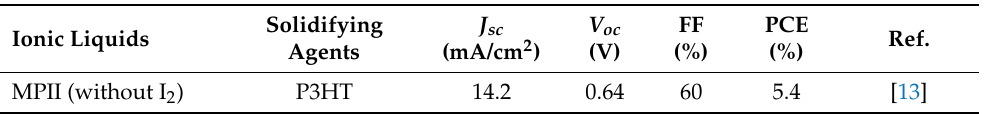
Table 1. Reported photovoltaic performance of sandwich-structured sDSSCs with an sRM based on ionic liquids and solidifying